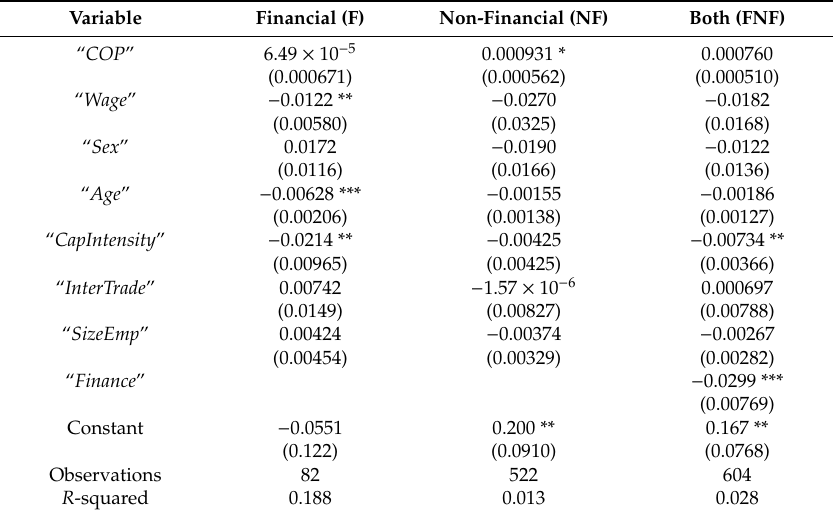
Table 10. Correlates of ROA for financial and nonfinancial